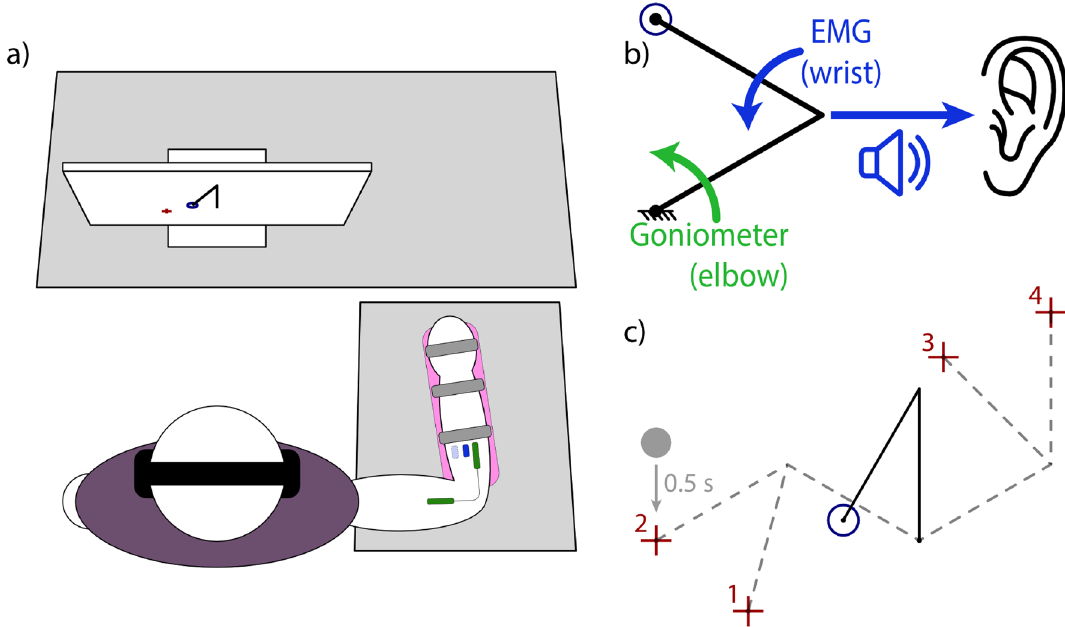
Figure 1. Center-Out Reaching Experiment Setup. ( a ) Subject arm is placed in a hand brace (pink), which rolls over across the table on a ball bearing cart. A goniometer (green) measures elbow angle, and EMG sensors (blue) measure EMG amplitude. ( b ) Goniometer angle (green) controls the position of the proximal link, and the EMG amplitude (blue) controls the speed of the distal link. Distal link speed is used for frequency- modulated audio feedback. ( c ) Subjects perform center-out reaches with the virtual limb (black), starting from the home circle (blue) and reaching for one of four targets (red), each of which can only be reached with a single limb configuration (dashed grey). Before each reach, a grey ball would appear above the target. When the limb endpoint left the home circle, the ball began to drop, centering on the target after half a second, signifying the end of the